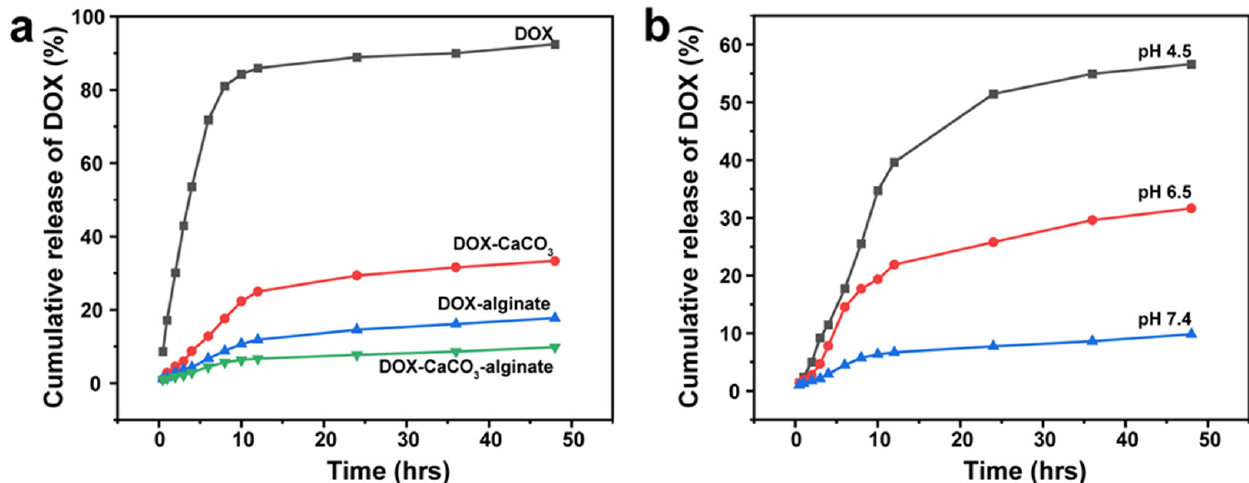
Figure 4. ( a ) In vitro cumulative release of the DOX components at pH 7.4 using DOX-CaCO 3 -alginate, DOX- alginate, DOX-CaCO 3 composites, and DOX powders. ( b ) In vitro cumulative DOX re- lease of the DOX components in the DOX-CaCO 3 -alginate composites at different pH values.